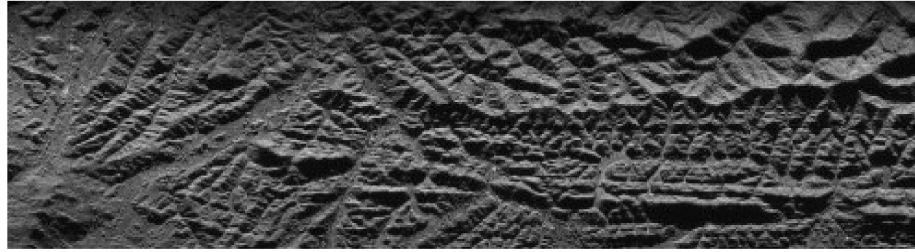
Figure 12. SAR image for echo simulation.